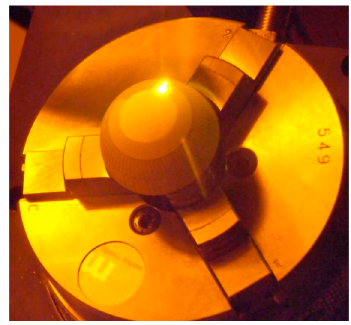
Figure 5. Camera picture showing the real-time laser texturing of the outer surface of the cup.